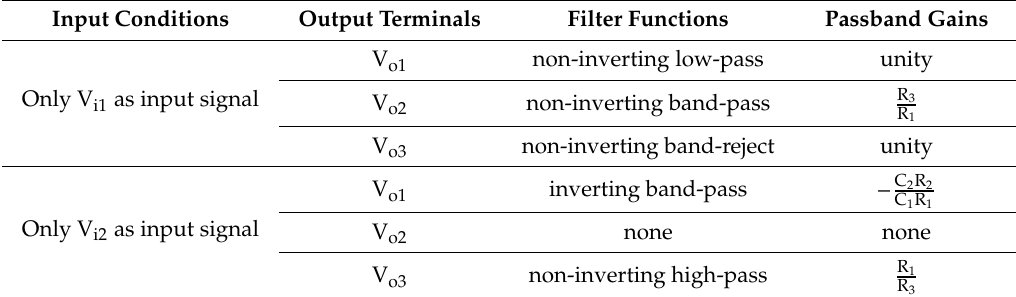
Table 2. Two inputs and three outputs filtering functions realized.